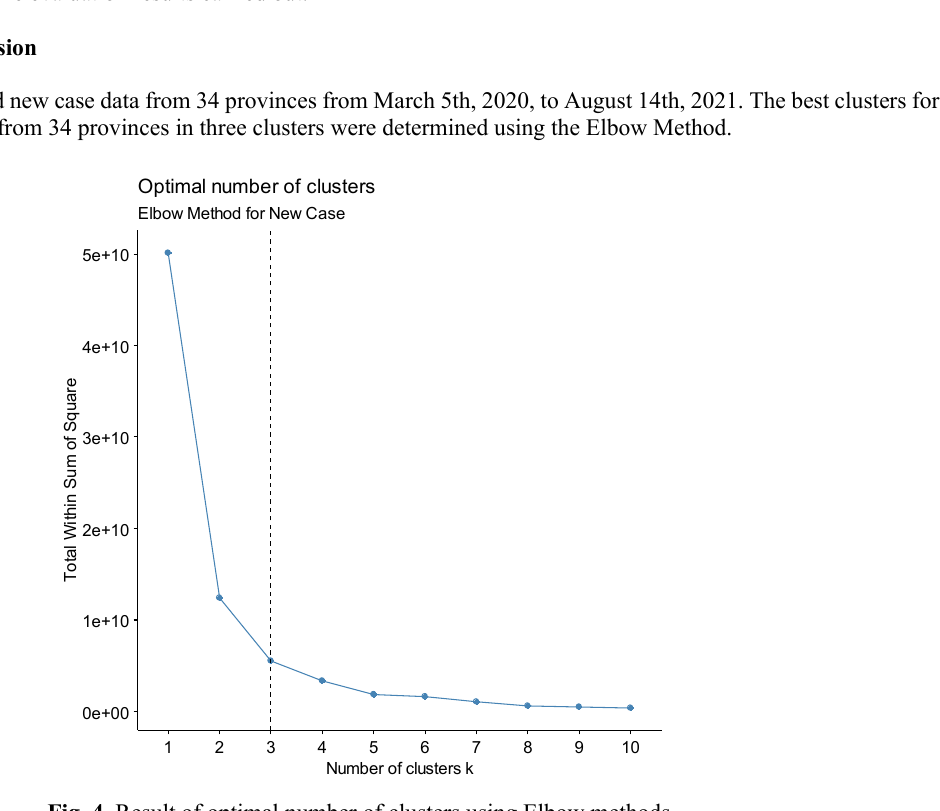
Fig. 4. Result of optimal number of clusters using Elbow